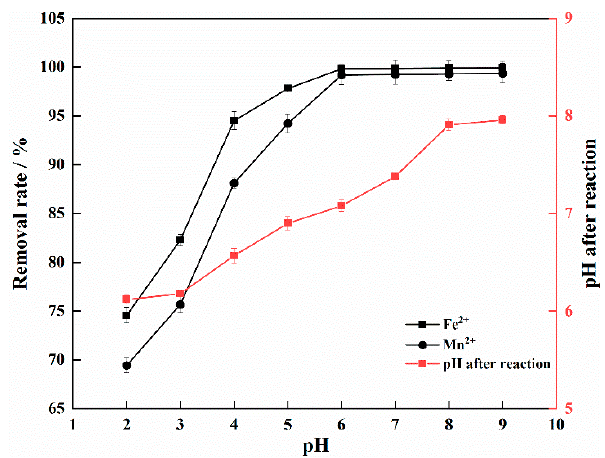
Figure 3. Effect of pH on the removal